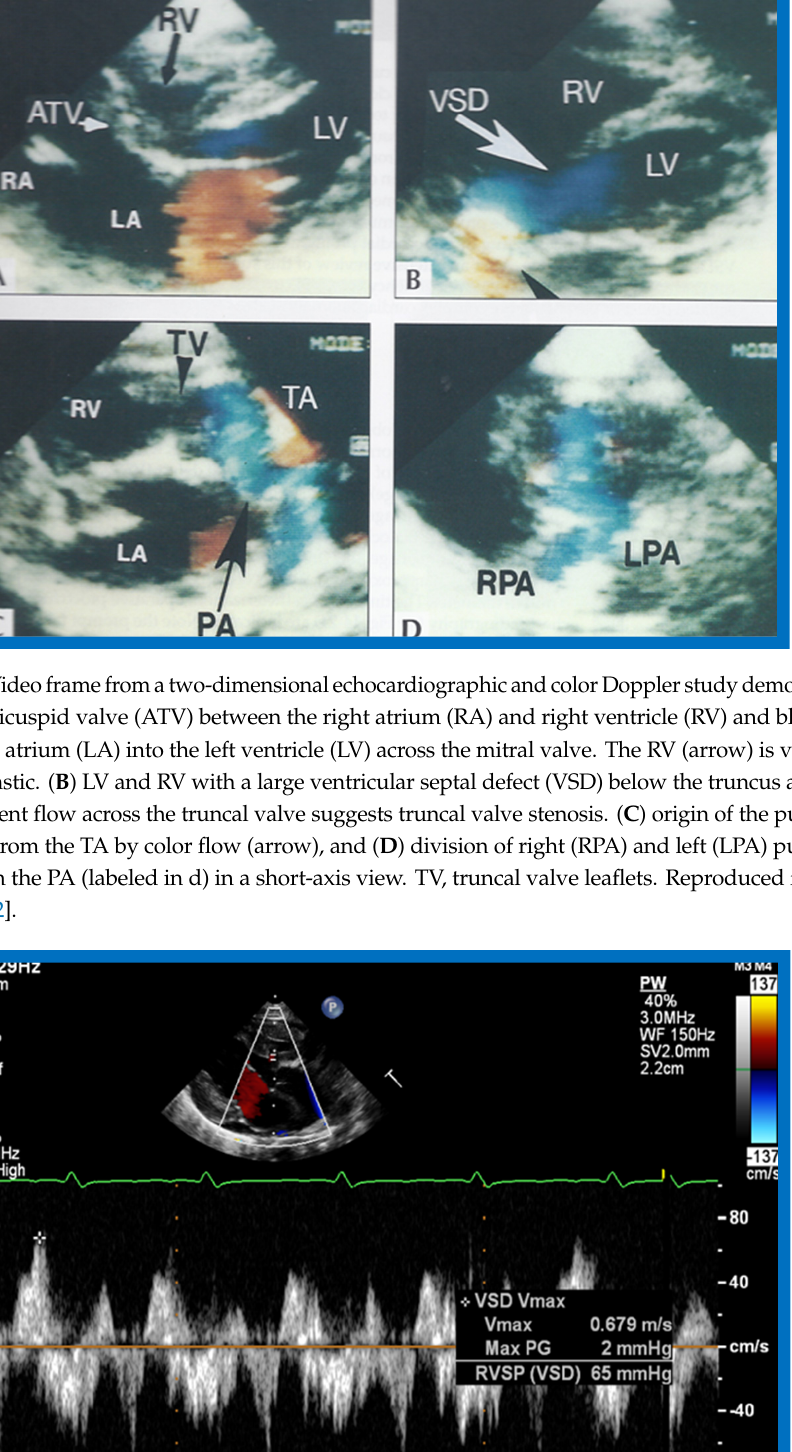
Figure 26. Selected video frames from suprasternal notch views of the aortic (Ao) arch in 2D ( A ) and color flow ( B ) images of a neonate with tricuspid atresia and transposition of the great arteries demonstrating coarctation of the aorta (CoA) and hypoplastic transverse aortic arch (TAA). The association of CoA with tricuspid atresia plus transposition of the great arteries is well known. DAo, descending aorta. Reproduced from Rao P.S. [39]. A large number of other cardiac defects are known to be associated with tricuspid atresia [37,38]. Consequently, echo ‐ Doppler studies should scrutinize for these defects during such studies. 7. Contrast Echocardiography in the Evaluation of Hypoxemia Following Open Heart Surgery We have used contrast echocardiography in other situations as well [8]. A three ‐ year ‐ old child had surgical correction of tetralogy of Fallot by patch closure of the VSD, resection of infundibular muscle and relief of valvar obstruction by a transannular pericardial patch. Following surgery, the child maintained good perfusion and normal vital signs, but had marked hypoxemia. Arterial PO 2 was around 30 torr with O 2 saturations in the mid 50s without any change in 100% O 2 . No cardiac